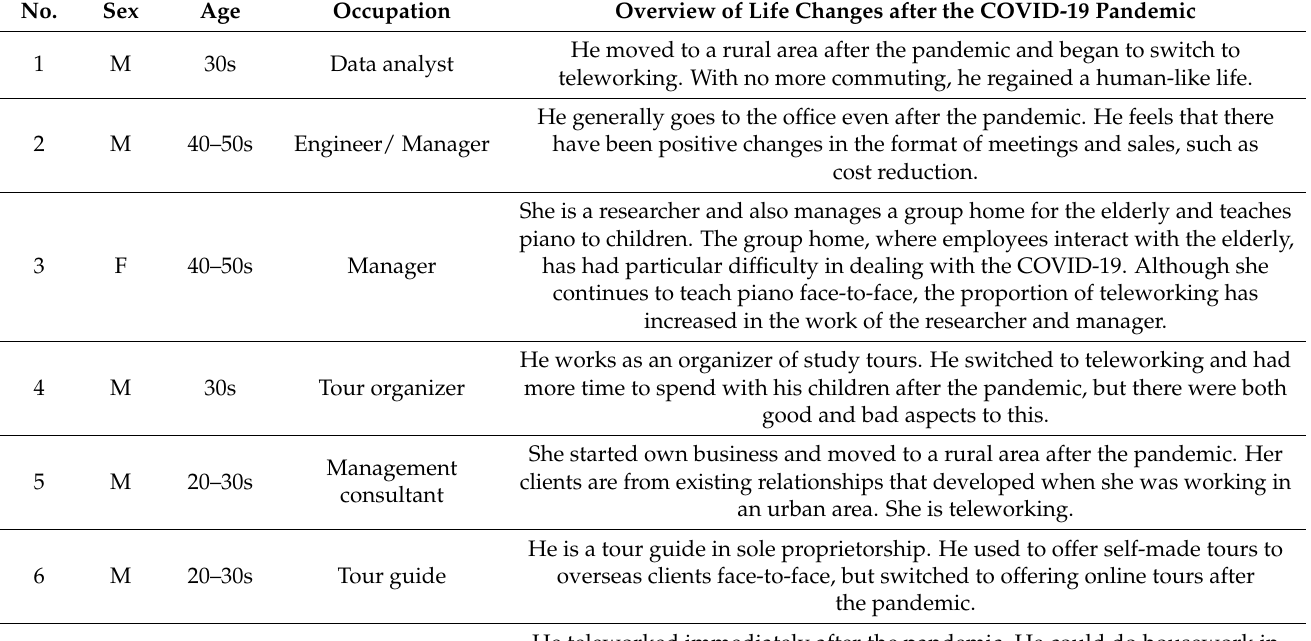
Table 1. Profile of